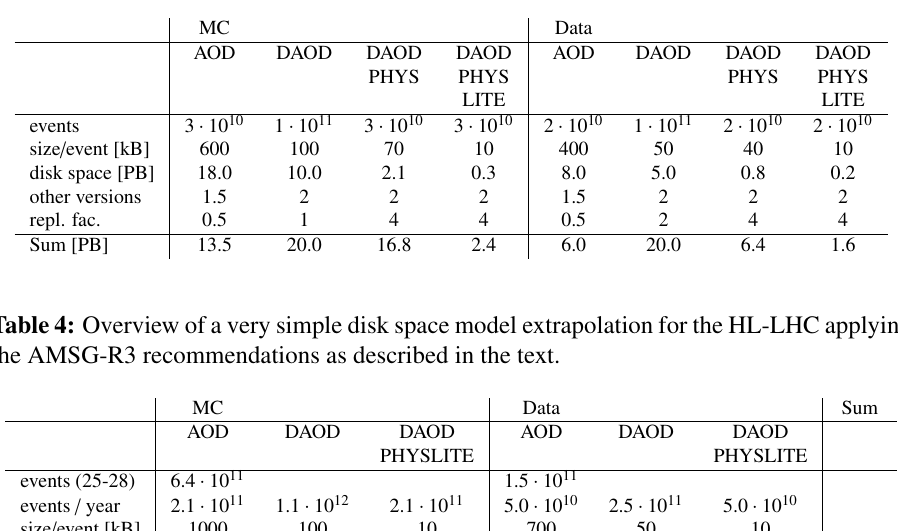
Table 3: Overview of a simple disk space model with Run-2 numbers and the AMSG-R3 recommendations applied as described in the text.